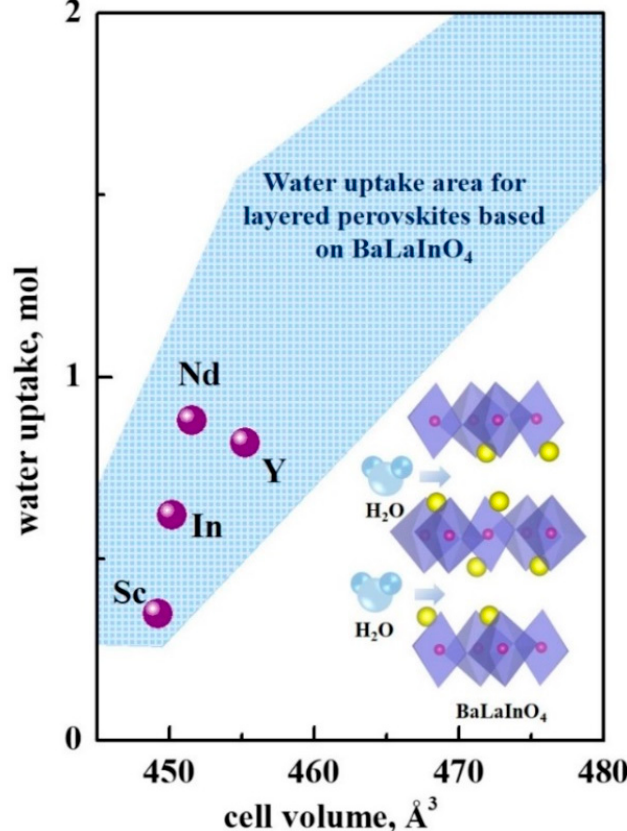
Figure 4. The dependency of water uptake vs. unit cell volume for the compositions BaLa 0.9 Nd 0.1 InO 4 (Nd), BaLaIn 0.9 Sc 0.1 O 4 (Sc) [54], BaLaIn 0.9 Y 0.1 O 4 (Y) [55], BaLaInO 4 (In) [49]. The blue area defines the water uptake area for the acceptor- and donor-doped compositions based on BaLaInO 4 with 0.1 mol dopant content [62]. Schematic illustration of water insertion into BaLaInO 4 structure is also shown.